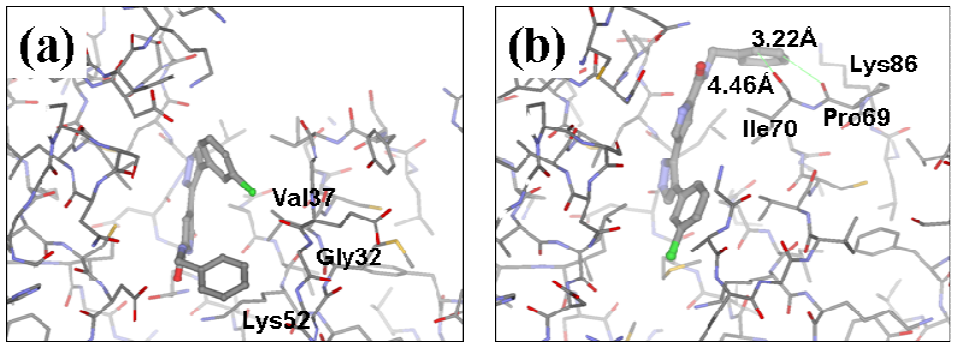
Figure 3. Structures of the complexes of 33A with (a) ERK2 and (b) JNK3, respect ively . Both the proteins and the ligand are displayed using stick models, with the ligand shown using thicker bonds . Co mparison of pan els (a) and (b) illus trate th e difference in orientation of 33A in the two structurally aligned proteins.